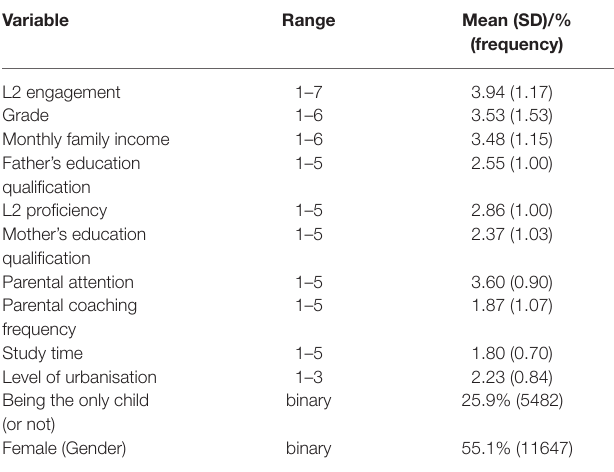
TABLE 1 | Participant profile ( N =